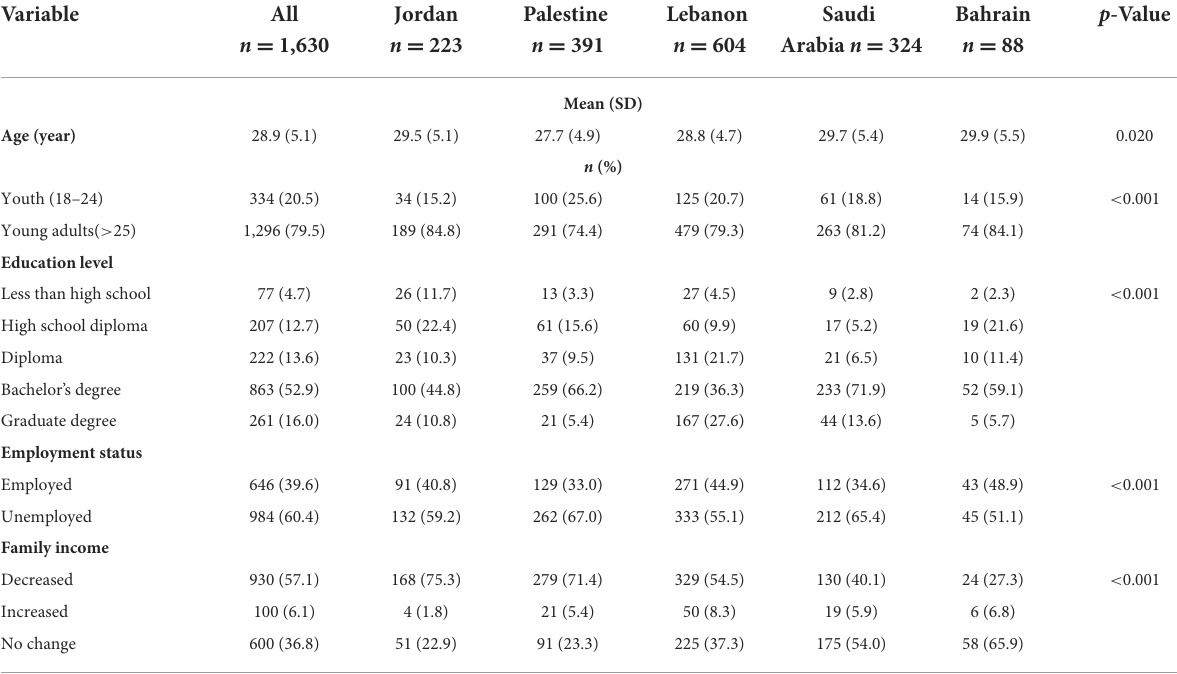
TABLE 1 Sociodemographic characteristics of the study postpartum women ( n = 1,630).